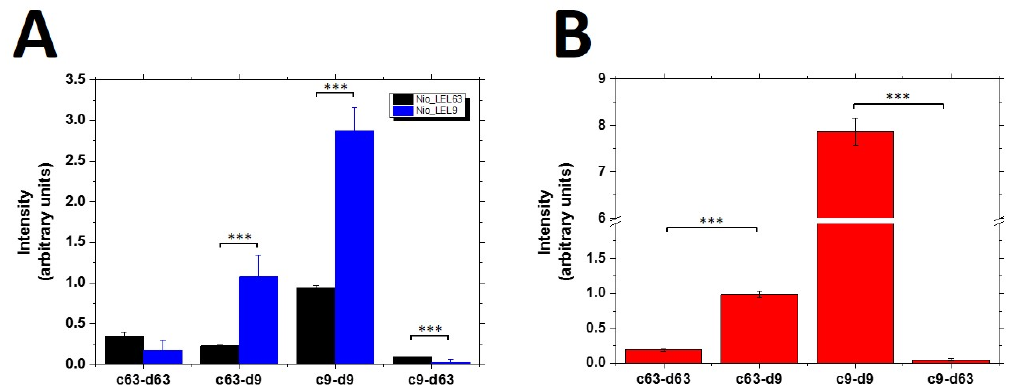
Figure 5. ( A ) ELISA assays for the detection of Nio_LEL9 and Nio_LEL63 fully artificial exosomes using different combination of capture “c” and detection “d” antibodies. Monoclonal α -CD9 or α - CD63 antibodies were used for capture, whereas polyclonal α -CD9 or α -CD63 antibodies were used for detection. Particle cross detection was used to measure unspecific recognition. ( B ) ELISA assays for the detection of Nio_LEL9/63 using different combinations of capture “c” and detection “d” antibodies. The graphs show the mean ± SD of 3 independent experiments. *** p ˂ 0.005, Student’s t -